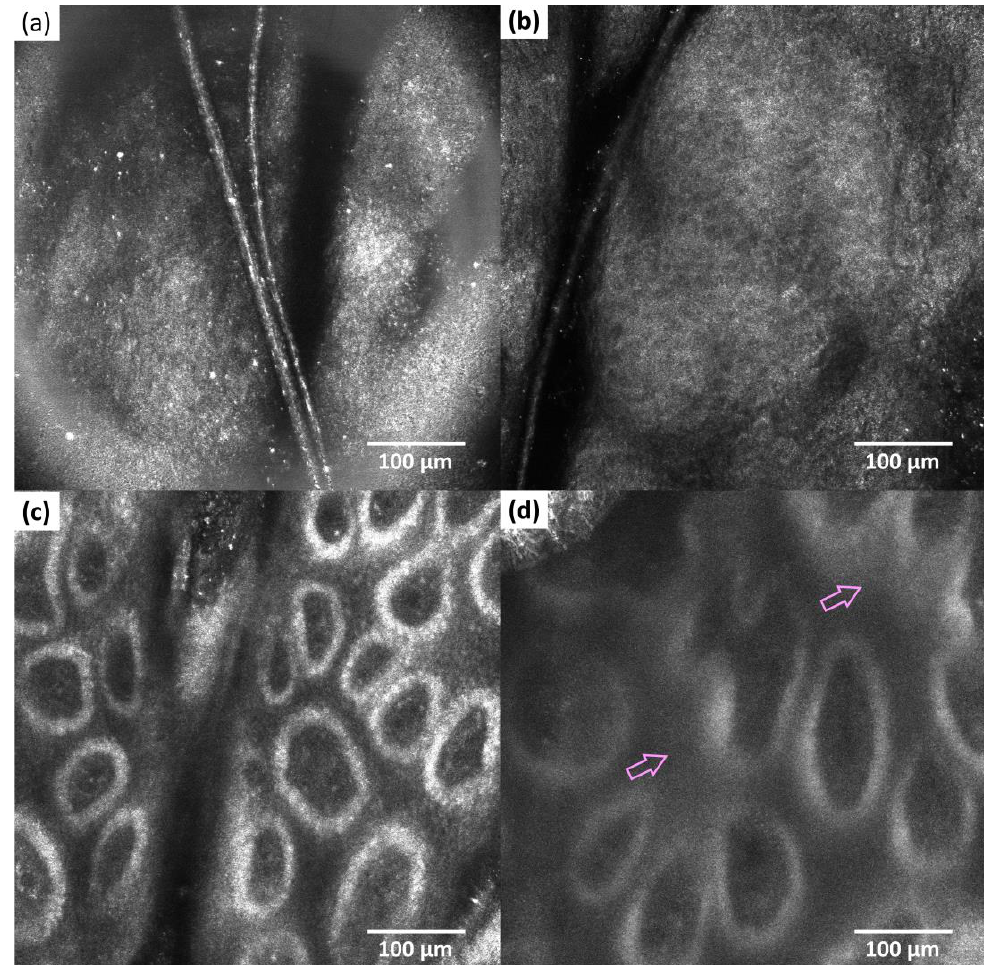
Figure 4. Reflectance confocal microscopy (RCM) images (500 × 500μm) of the antecubital right fossae 3 weeks after treatment—right forearm ( a ) cornified layer; ( b ) granular/spinous layer with restored regular honeycomb pattern; ( c ) dermal-epidermal junction—visible bright rings surrounding the dermal papillae; decreased accumulation of inflammatory cells in the dermal papillae ( d ) fuzzy aspect of dermis with the appearance of a blurred reticulated meshwork (purple arrow).